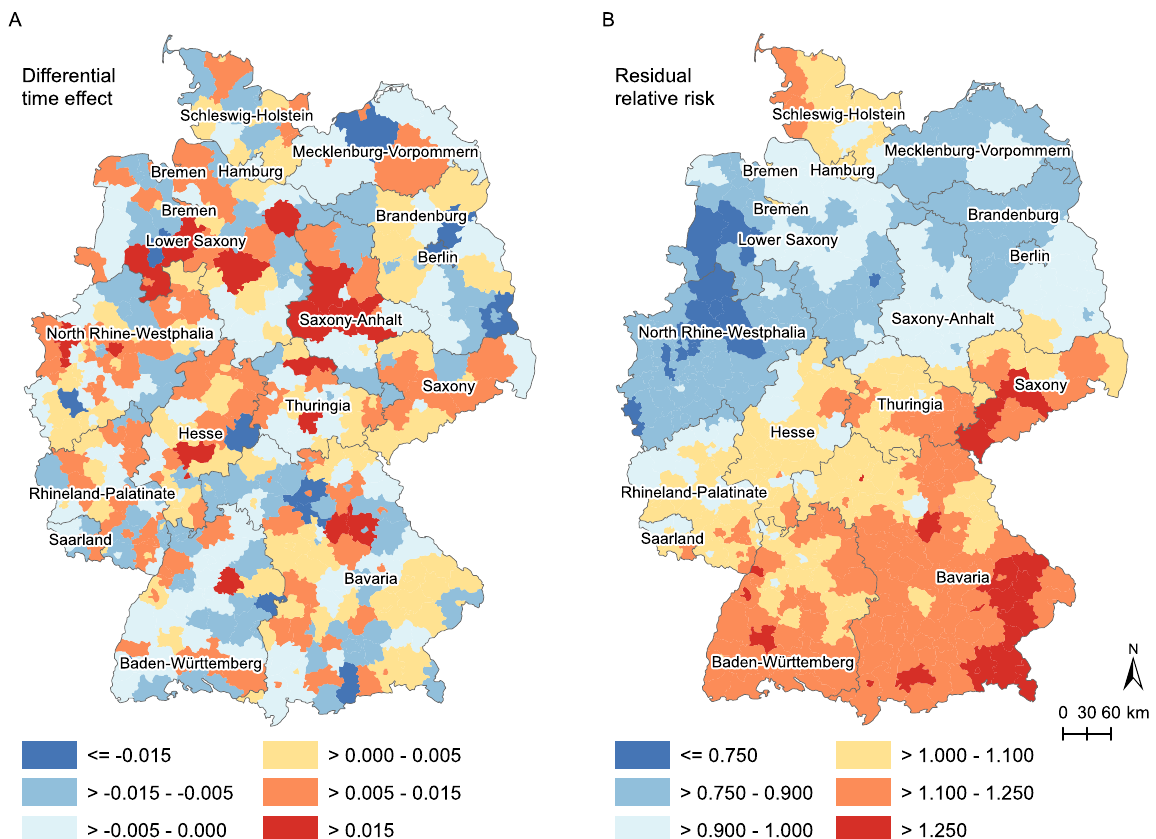
Figure 2. Differential time effect ( A ) and residual relative risk ( B ) per district (model 1b). Maps were created with ArcGIS 10.4.1